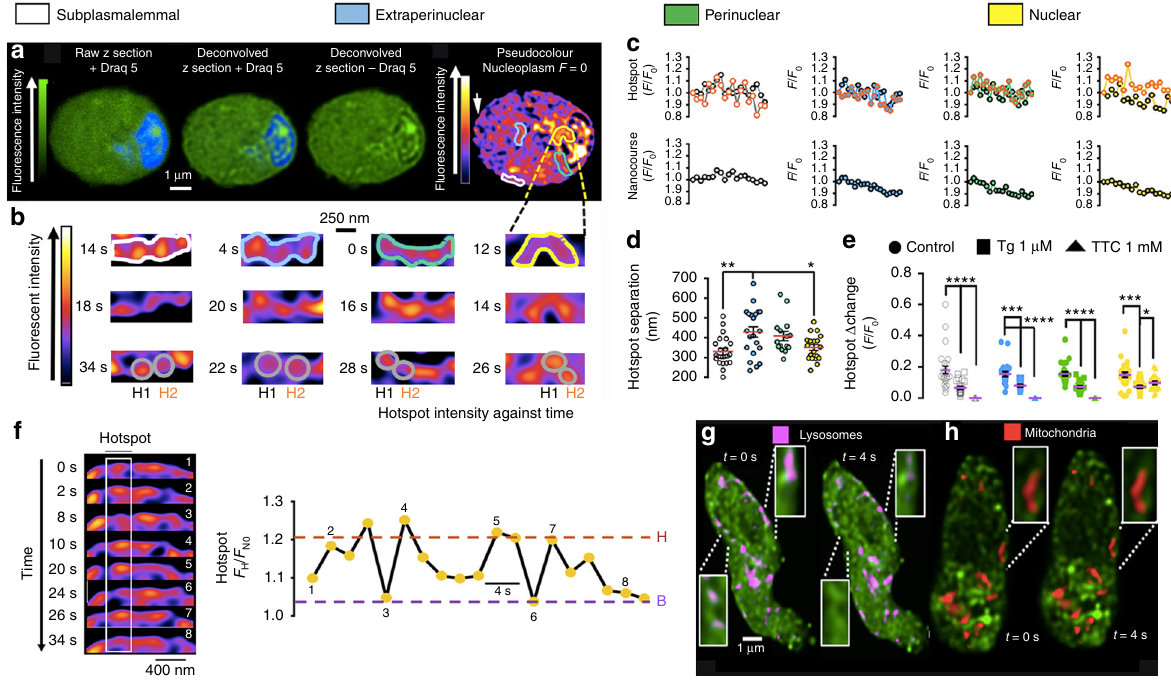
Fig. 2 SR Ca 2 + fl ux within a cell-wide circuit of cytoplasmic nanocourses of arterial myocytes. a (left to right), confocal z sections through acutely isolated arterial myocyte loaded with Fluo-4 (green, calcium indicator) and Draq 5 (blue, nucleus), then deconvolved, and pseudocolor applied to show relative Fluo-4 intensity. Regions of interest identify exemplar subplaslemmal (white), extraperinuclear (blue), perinuclear (green) and nuclear (yellow) nanocourses. b (left to right), nanocourses in ( a ) at higher magni fi cation and different time points; note, thresholds set independently to visualise hotspots. Grey circles identify hotspots (H1, black; H2, orange) of Ca 2 + fl ux in exemplar nanocourses. c Fluo-4 fl uorescence ratio ( F x / F 0 ; where F 0 = fl uorescence at time 0 and F x = fl uorescence at time = x) versus time (sampling frequency = 0.5 Hz) for H1 and H2 (upper panels, left to right) and the average for the whole nanocourse (lower panels, left to right). d Scatter plot shows distances separating hotspots (mean ± SEM; ≥ 36 hotspots, n = 7 cells from 7 rats) within subplasmalemmal (white), extraperinuclear (blue), perinuclear (green) and nuclear (yellow) nanocourses. e Dot plots show the effect of thapsigargin (1 µ M; 30 min pre-incubation; n = 3 cells from 3 rats) and tetracaine (1 mM; 4 h pre-incubation; n = 5 cells from 4 rats) on the amplitude (mean ± SEM) of Fluo-4 fl uorescence ratio change ( Δ F X / F 0 ); t -test with Welch ’ s correction: * p < 0.05, ** p < 0.01, *** p < 0.001, **** p < 0.0001. f Image time series highlights (white rectangle) time-dependent intensity fl uctuation of one hotspot in a different subplasmalemmal nanocourse (arrow in ( a ), upper panel, right most image), with a record of fl uorescence intensity against time ( Δ F H / F N0 ; H = hotspot, N 0 = nanocourse at time = 0) from basal (B) to high intensity (H) states; note prolonged sub-state. g Deconvolved time series of z sections (0.25 Hz) show LysoTracker Red labelled endolysosomes in cytoplasmic nanocourses identi fi ed by Fluo-4 (con fi rmed in 3 cells from 3 different animals). h As for ( g ), but for mitochondria labelled with MitoTracker Red (con fi rmed in 3 cells from 3 different animals). Pseudocolour look up tables in ( a ) and ( b ) indicate relative fl uorescence intensity in arbitrary units